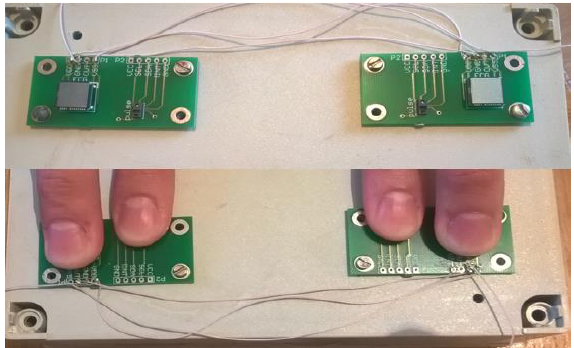
Fig. 3. The sensors (above) and the biosignals reading